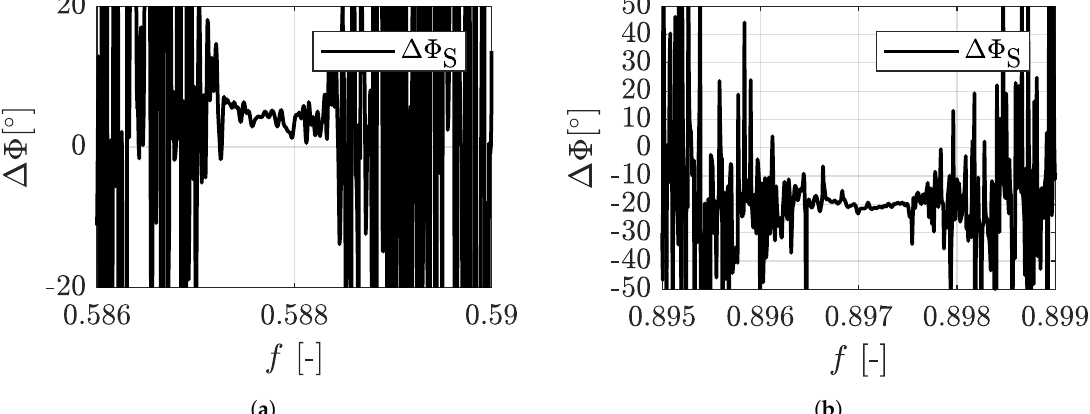
Figure 10. Vibratory Modes 6 and 9: Shaft vibrations, frequency domain and phase lag. ( a ) Phase lag of both shaft SGs during resonance M6 in the frequency domain; ( b ) Phase lag ∆ Φ S of shaft SGs during resonance